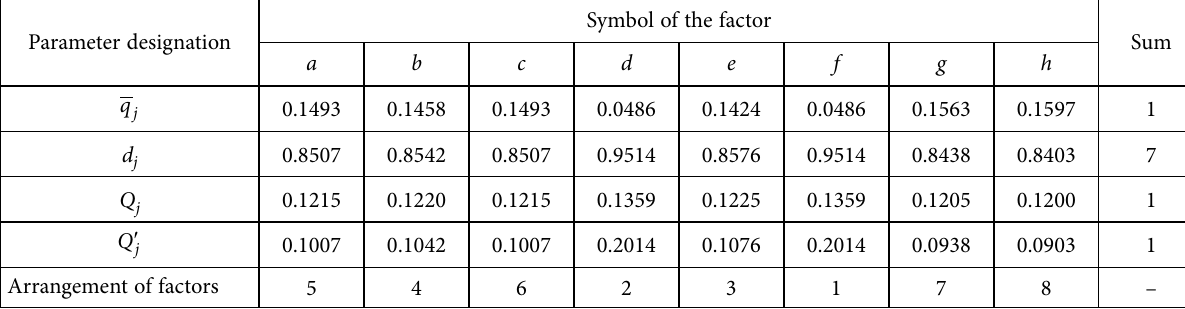
Table 2. Table or ranking assessment (source: compiled by the